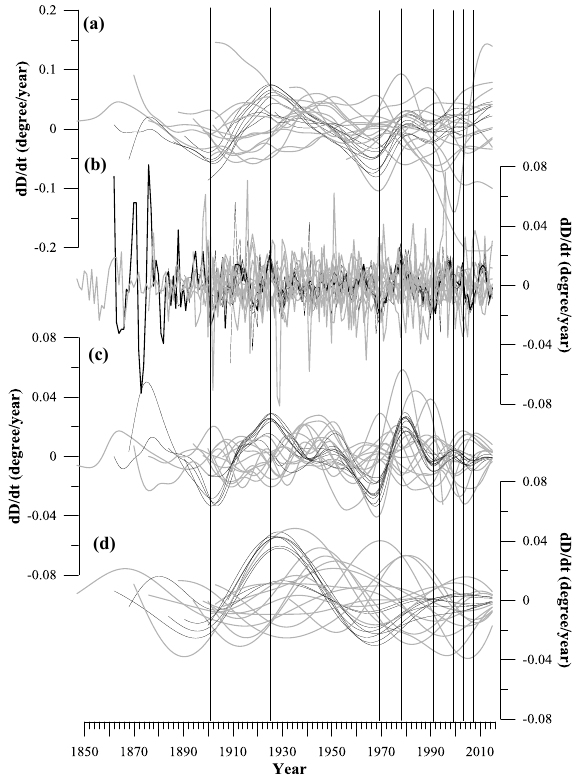
Figure 6. Constituents of the first time derivative of the declina- tion at all analyzed observatories (European time series in black and non-European in gray). From (a) to (d) : the trend from an HP filter- ing, the cyclical constituent from an HP filtering, the inter-decadal constituent of the trend, and the sub-centennial constituent of the trend. Vertical lines mark the generally accepted 20th century geo- magnetic jerks.